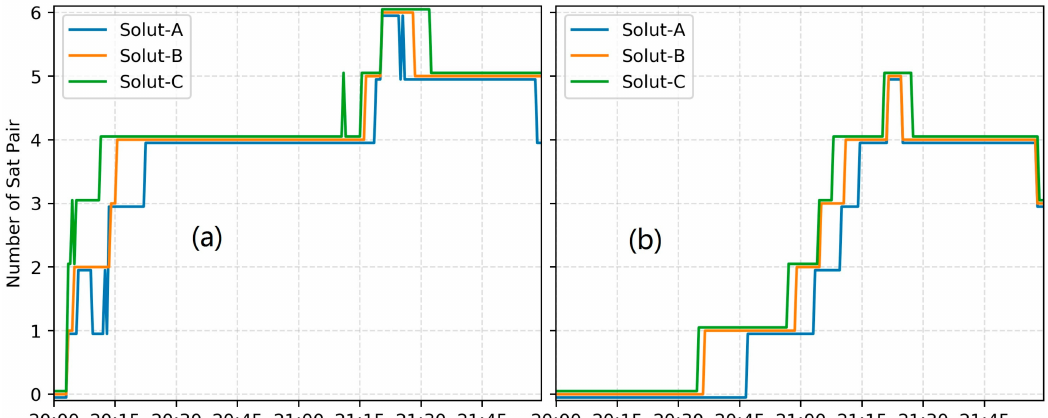
Figure 6. Time series of the number of BDS WL and NL resolved ambiguities for solution A, B and C, respectively. ( a ) the number of BDS WL resolved ambiguities; ( b ) the number of BDS NL resolved